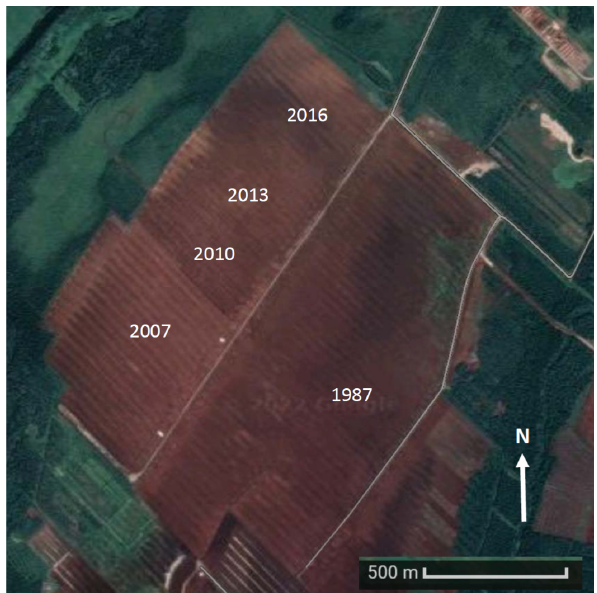
Figure 1. Location of measured sectors within the study site. Image modified from Google Maps (Imagery © 2022 CNES/Aribus, Imagery© 2022 CNES/Airbus, Landsat, Coperni- cus, Maxar Technologies, Map data© 2022) (© Google Earth: https://www.google.ca/maps/@47.7910172,-69.5156644,3144m/ data=!3m1!1e3!5m1!1e4), last access: 6 July 2022). The field labels show the year the sectors were opened for peat